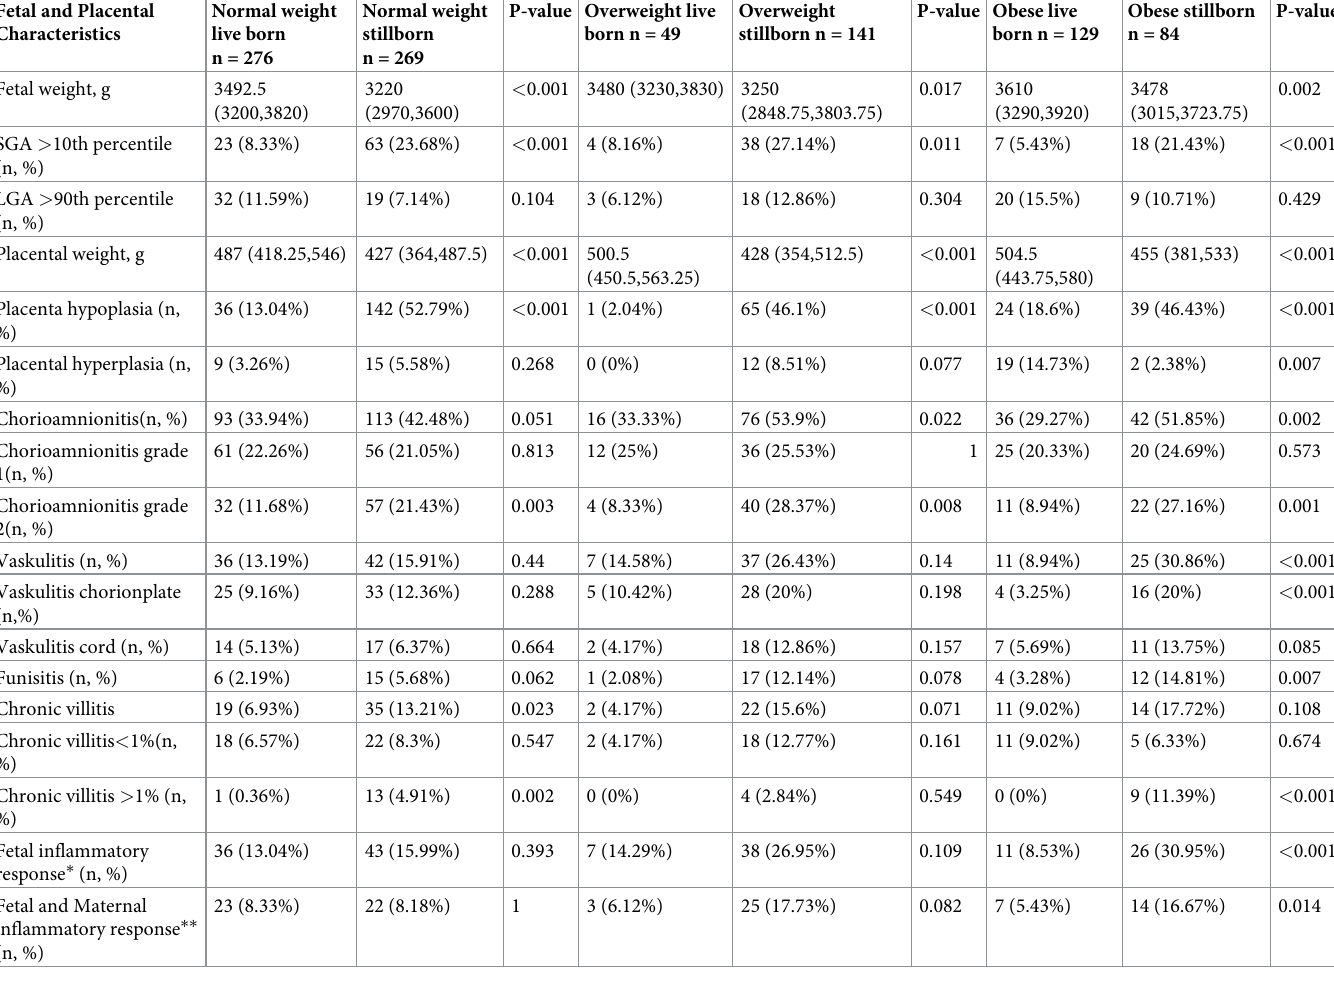
Table 3. Placental inflammatory lesions from term pregnancies with live born infants and stillborn infants according to pre-pregnancy maternal BMI. For continu- ous variables medians with interquartile range are expressed and for categorical variables numbers and proportions are expressed. Fetal and Placental